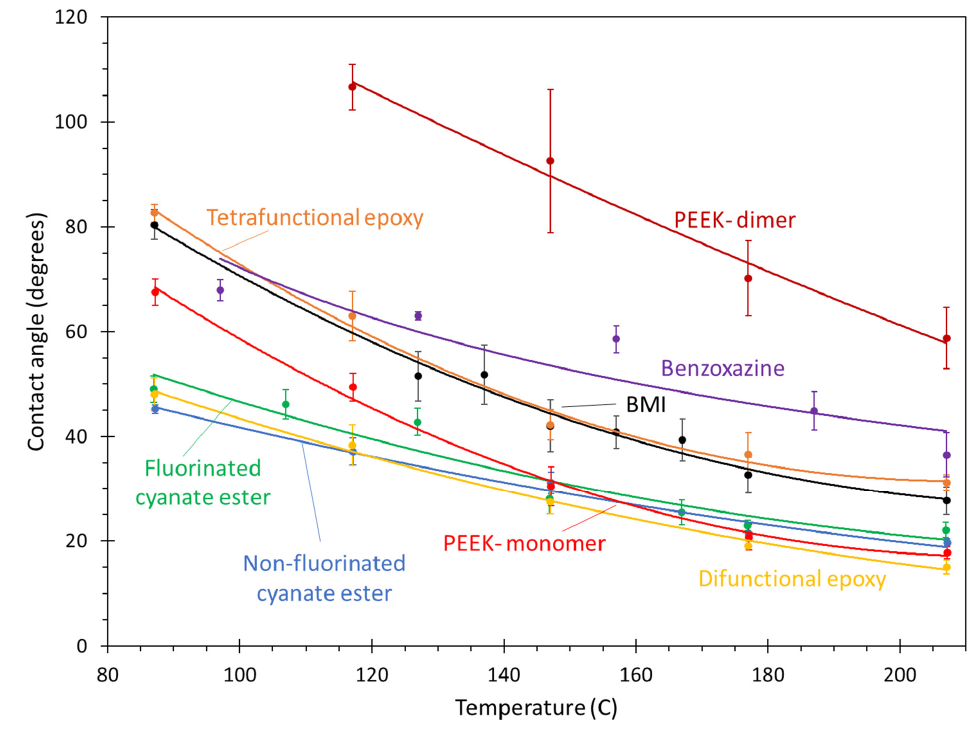
Figure 22. Plot of contact angle vs. temperature of monomers on the aromatic surface. The lines are curve fits to the data, and the error bars represent the standard error of replicate predictions.